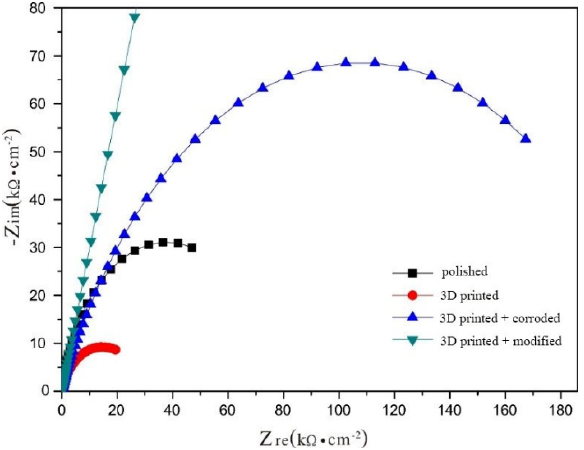
Figure 8. Nyquist plots of different samples.